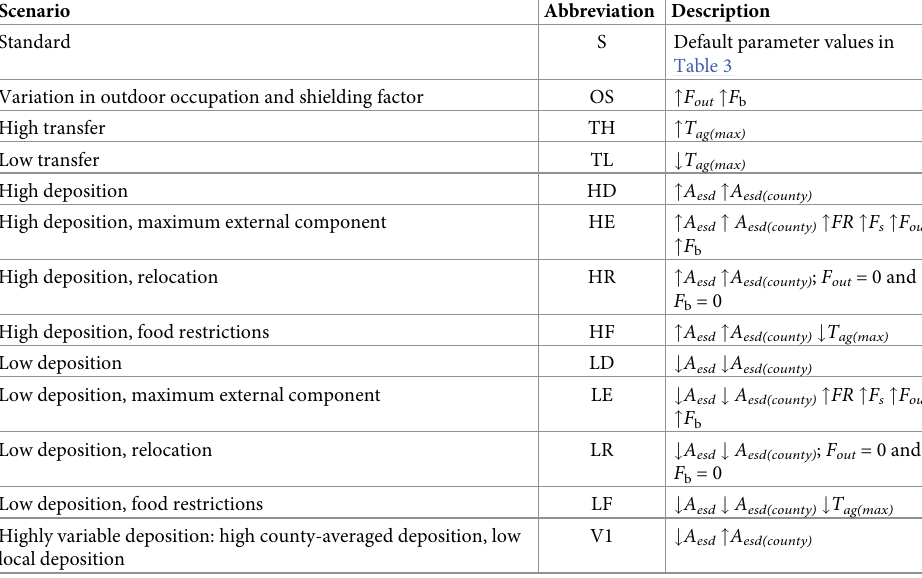
Table 2. Description of the modelled scenarios.